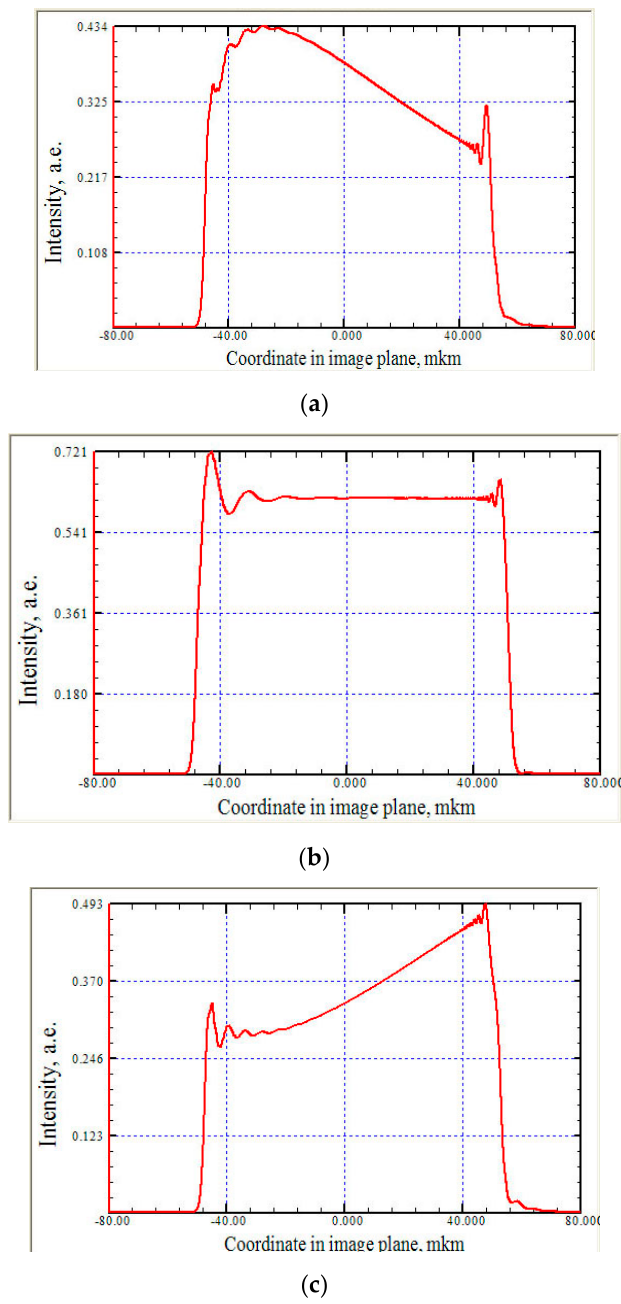
Figure 2. Modulation of the beam cross-section in a slit monochromator system at various normalized angles of alignment of the crystal analyzer (reflection Si (220), Cu 𝐾 𝛼 , θ Br = 23.652 ° ): ( a ) y = 1.05; ( b ) y = 0; ( c ) y = -1.05. Other parameters: An extended rectangular source ξ s = 100 μ m, located at a distance of 40 m, illuminates a slit size of a = 100 μ m; the distance of the slit analyzer is 5 cm; the asymmetry coefficient of the crystal b = 1.